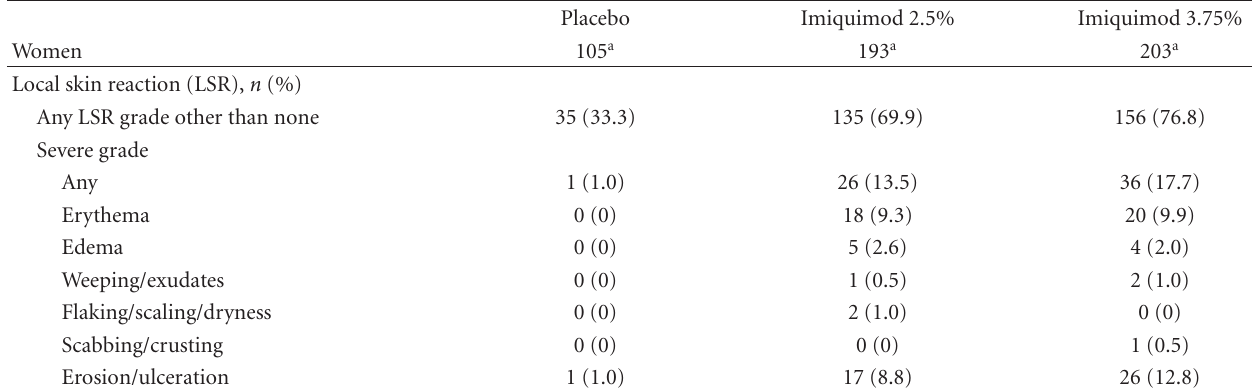
Table 4: Summary of local skin reactions, maximum intensity during evaluation